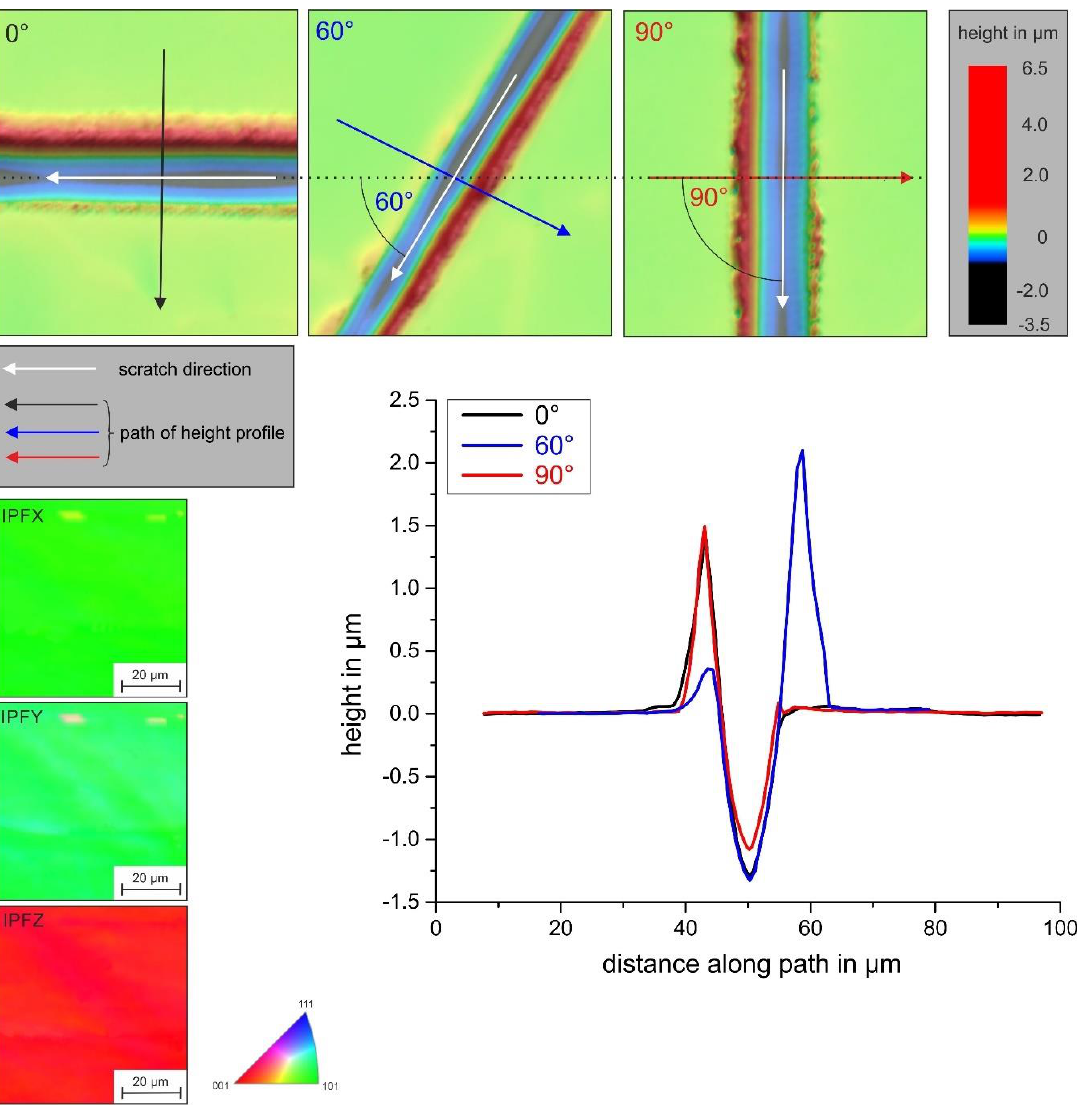
Figure 13. Pile-up formation in the nearly (001)-oriented DS specimen (parallel to the longitudinal specimen axis) as a function of scratch orientation.